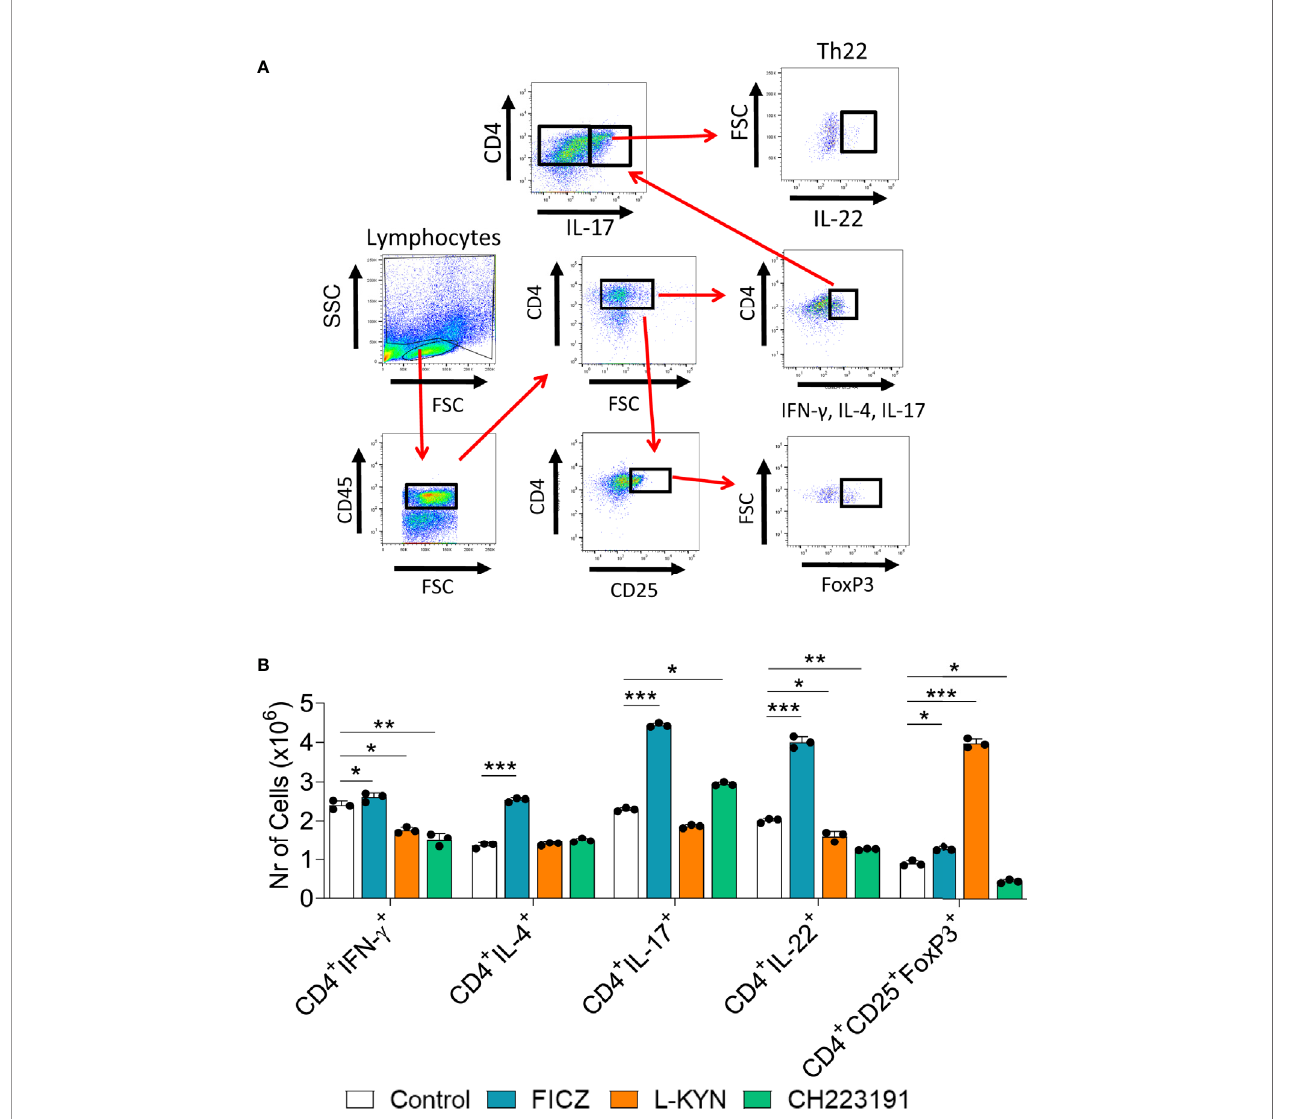
FIGURE 10 | Treatment with AhR ligands alters the differentiation and migration of CD4+ T cell subsets to the lungs of P. brasiliensis infected mice. C57BL/6 mice were infected with 1 x 10 6 P. brasiliensis yeasts and treated on alternate days with FICZ, L-Kyn, or CH223191 at doses of 200, 800, or 400 m g/animal, respectively. Control mice were treated with PBS. The animals were sacri fi ced 2 weeks after infection, their lungs removed, macerated and the CD4+ T lymphocytes evaluated by fl ow cytometry for intracellular expression of Th signature cytokines (IFN- g , IL-4, IL-17, IL-22) and the Treg phenotype (CD4+CD25+Foxp3+). (A) Gate strategy to de fi ne T cell subsets. (B) Number of Th1, Th2, Th17, Th22, and Treg cells present in the lungs of control and AhR ligands treated mice. The experiment was repeated twice, and data are expressed as M ± SD. P values < 0.05 were considered signi fi cant (* p < 0.05; ** p < 0.005 and *** p <